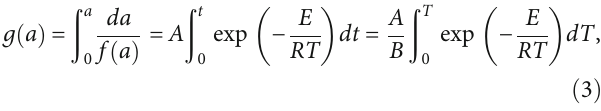
Figure 7: Activation energies derived from the KAS method as a function of conversion for samples with di ff erent GE contents.